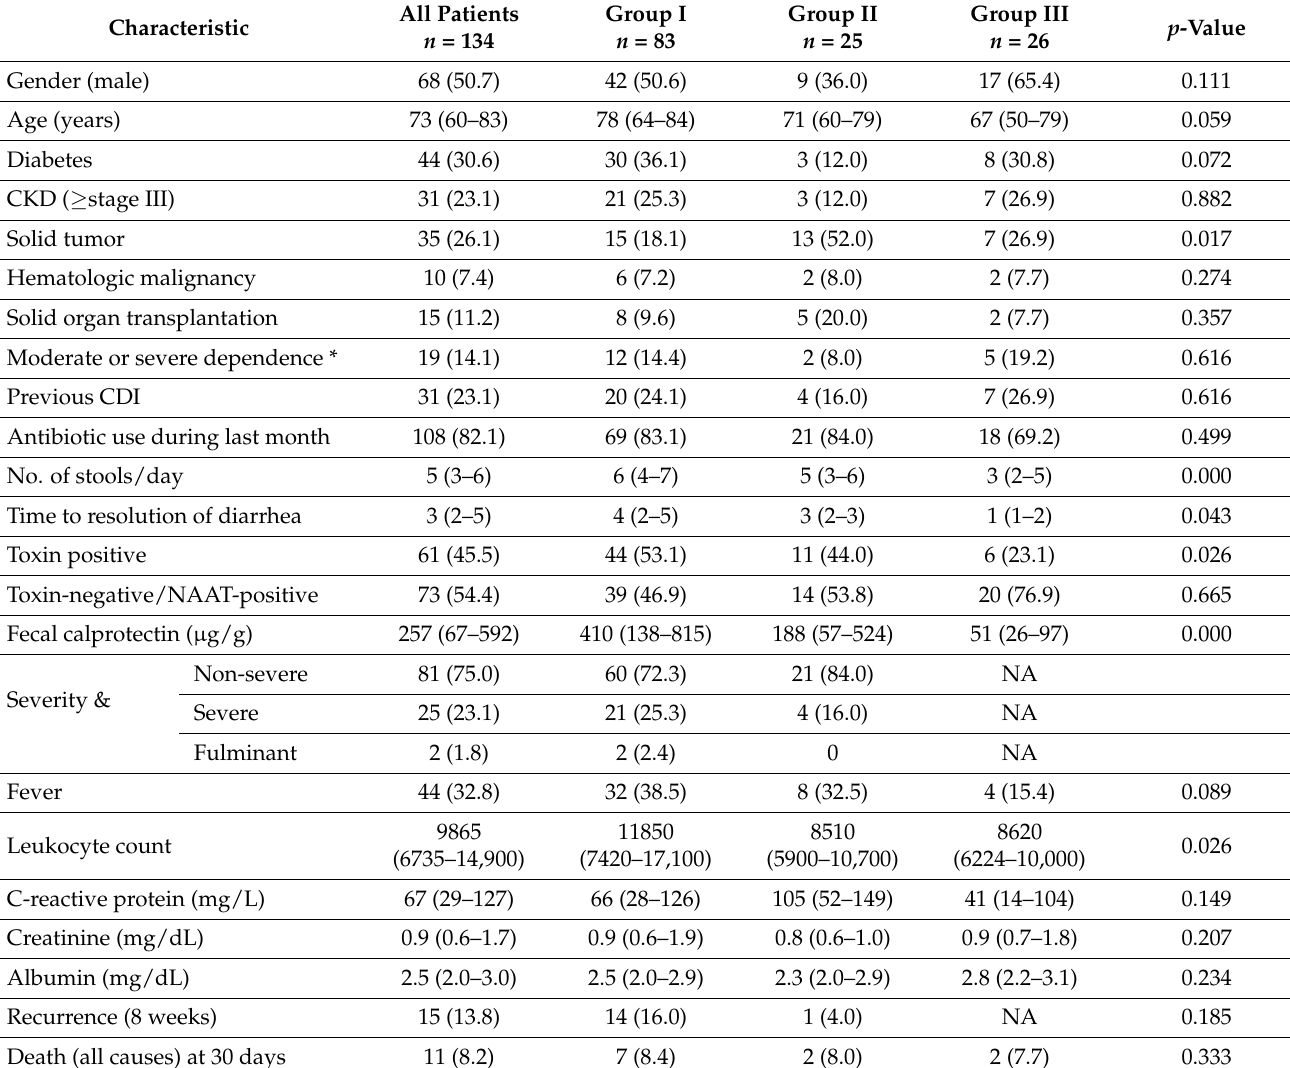
Table 1. Comparison of cohort patients by groups (presumed C. difficile infection treated, group I; doubtful C. difficile infection treated, group II; and non-treated patients, group